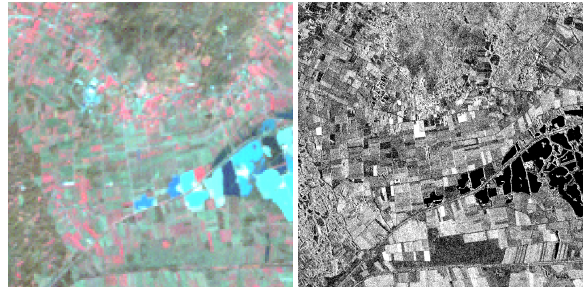
Figure 1. Study area images in Landsat 7 ETM+ colour infrared composition (left) and TerraSAR-X